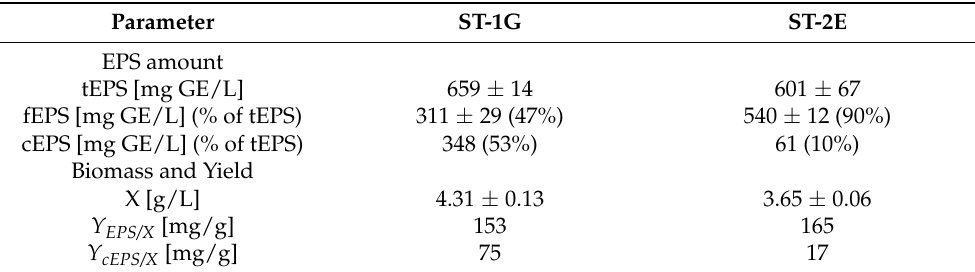
Table 1. EPS amount ( n = 6), biomass ( n = 3) and yield of enriched whey permeate media fermented with S. thermophilus ST-1G or ST-2E. Values are shown as means ± standard deviation 1 . Parameter ST-1G ST-2E EPS amount tEPS [mg GE/L]